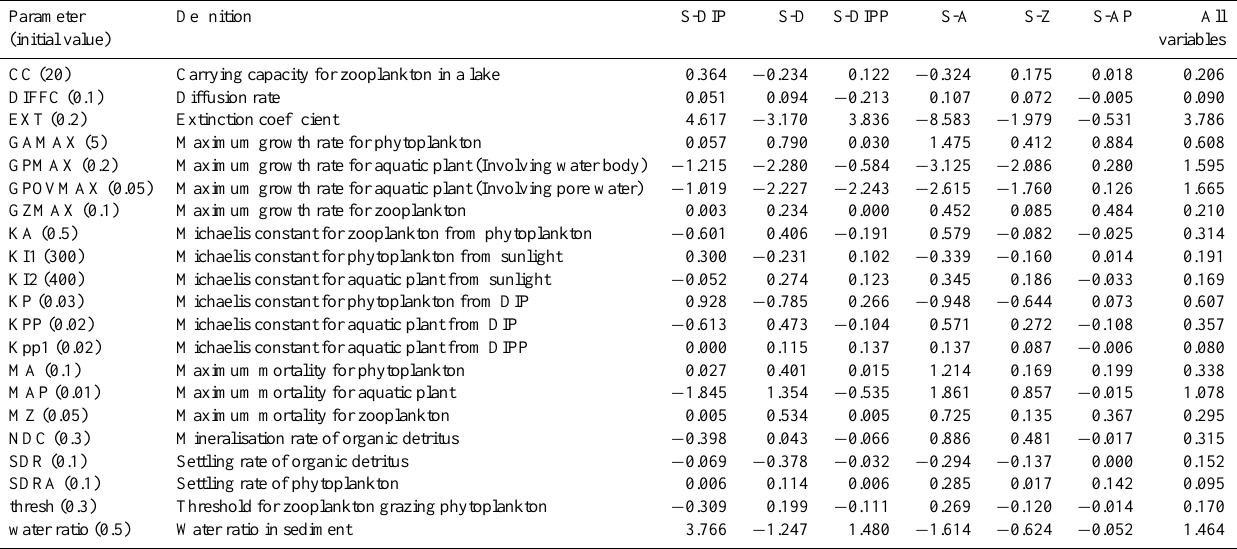
Table 3. Sensitivity indices of parameters in the ecological model. Parameter